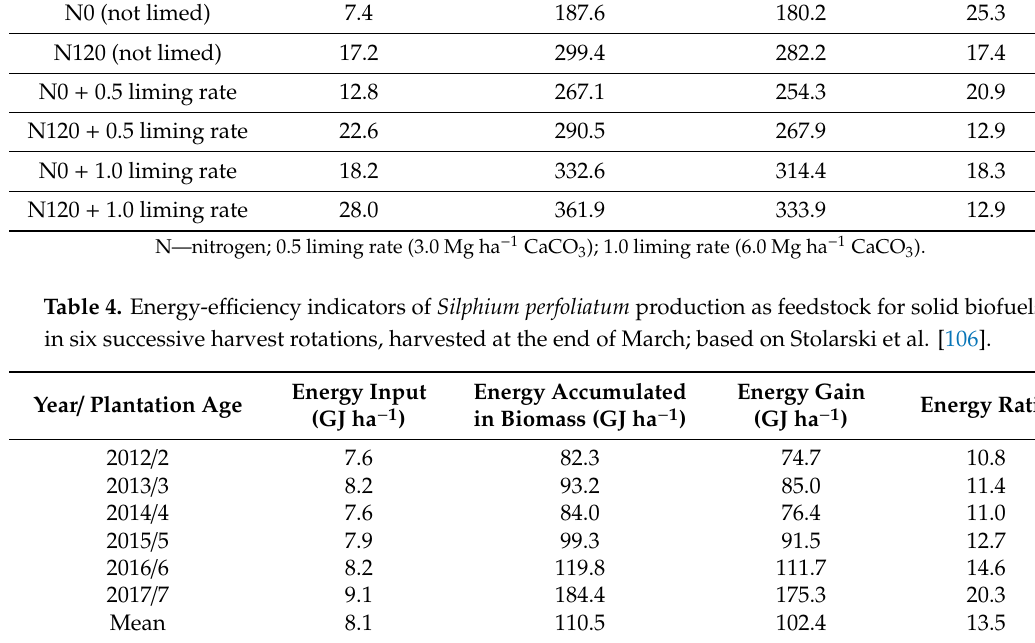
Table 3. Energy-e ffi ciency indicators of Silphium perfoliatum for di ff erent types and rates of fertilization, harvested at the end of September; based on Šiaudinis et al. [54]. Energy Input Energy Accumulated Fertilization Rate (GJ ha − 1 ) in Biomass (GJ ha − 1 )